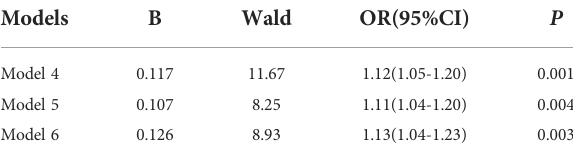
TABLE 5 Binomial logistic regression analysis adjusted ORs (95% CIs) for the associations between PrFT and the risk of